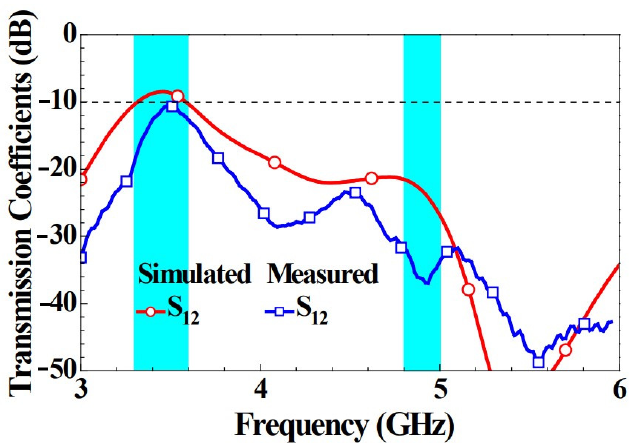
Figure 6. Simulated and measured transmission coefficients for Ant 1 and Ant